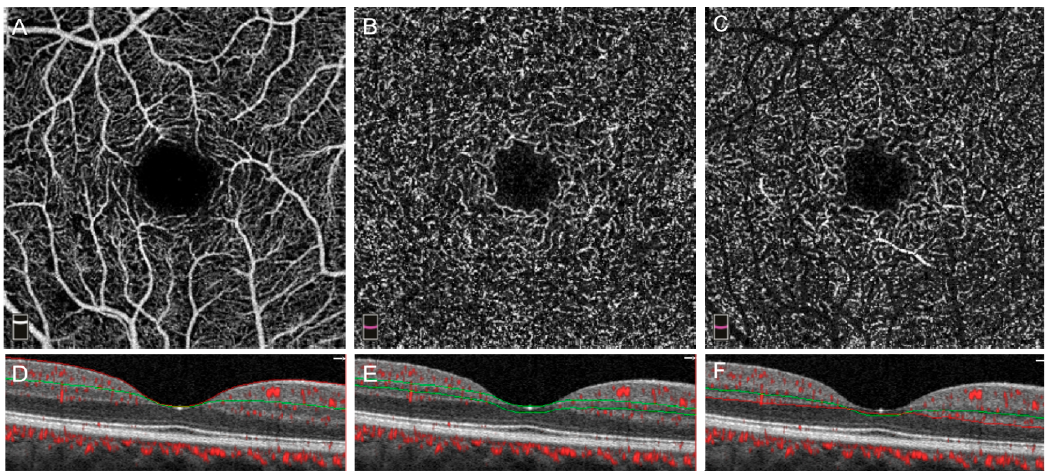
Figure 2. OCTA image segmentation. Panels ( A – C ) show the respective en ‐ face angiograms of the superficial, middle, and deep capillary plexuses with cross ‐ sections shown in ( D – F ) with angio overlay.